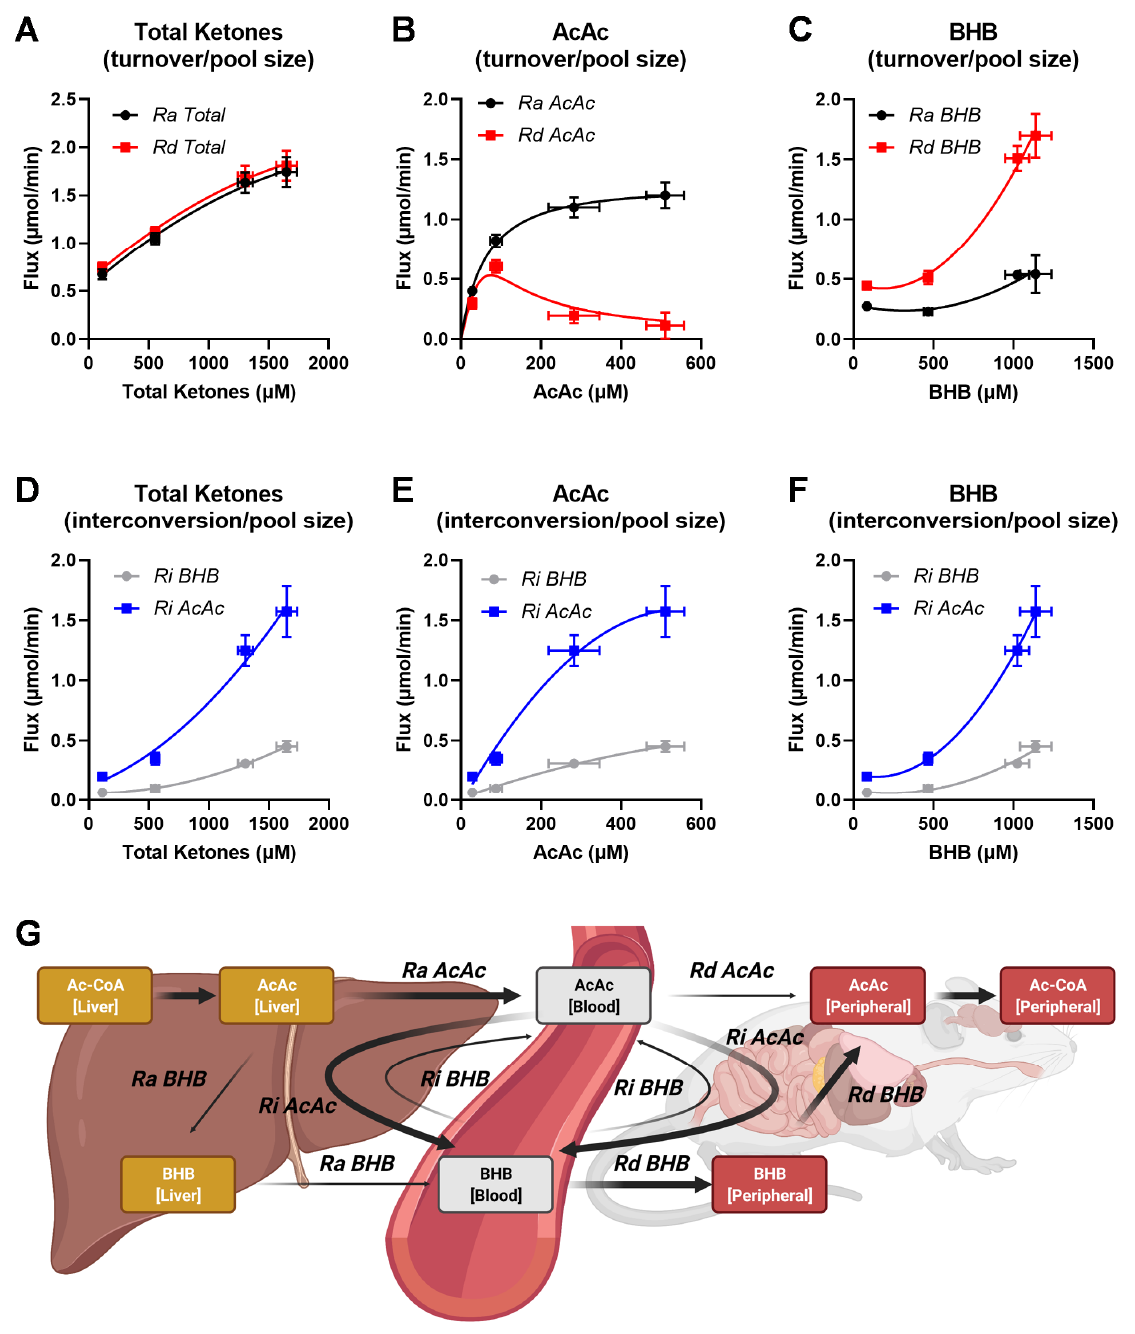
Figure 8. The relationship between fluxes and individual ketone pool sizes. Ketone turnover in relationship to pool size: ( A ) total ketones, ( B ) AcAc, and ( C ) BHB. Relationships between interconversion flux and the individual plasma pool sizes for ( D ) total ketones, ( E ) AcAc, and ( F ) BHB. Ra —rate of appearance, Rd —rate of disposal, Ri —rate of interconversion. ( G )